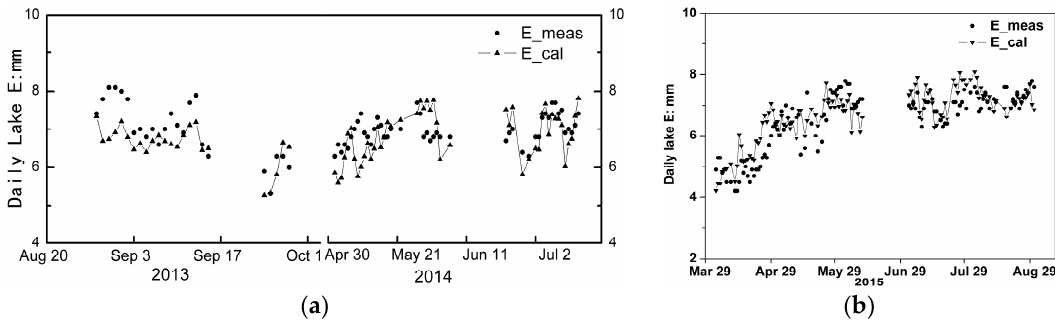
Figure 4. Calibration ( a ) and validation ( b ) of the daily evaporation model. Table 4. Statistical index of model calibration (Cal.) and validation (Val.).